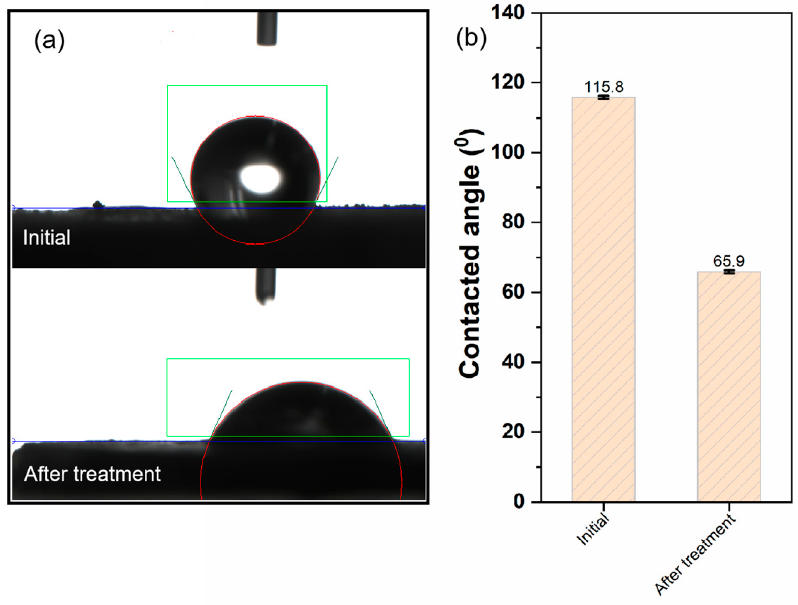
Figure 7. Contacted angle images ( a ) and values ( b ) of shale gas OBDCs before and after treatment by using DMCHA.